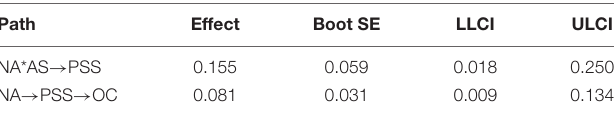
TABLE 4 | Results of moderation effects analysis of abusive supervision using